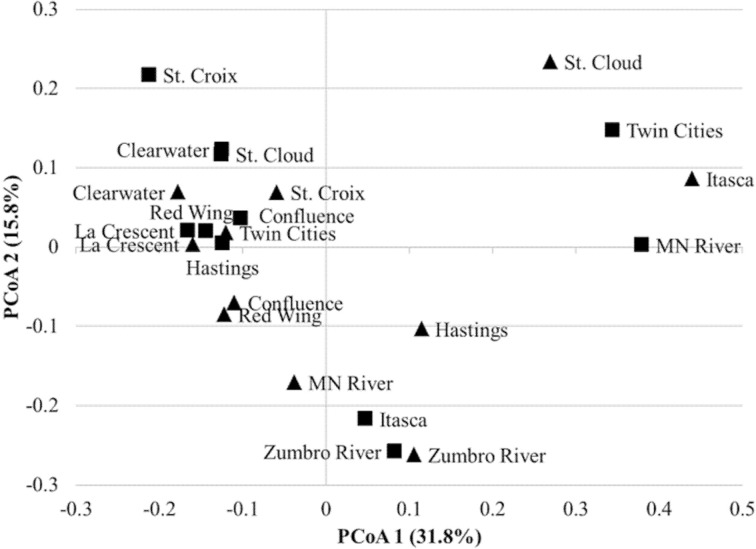
Principal coordinate analysis of bacterial communities from 2011 (▴) to 2012 (∎) samples (r2 = 0.848). All replicates were merged for ordination only; statistics were calculated with replicates separated. A total of 20 axes were necessary to explain all variation.